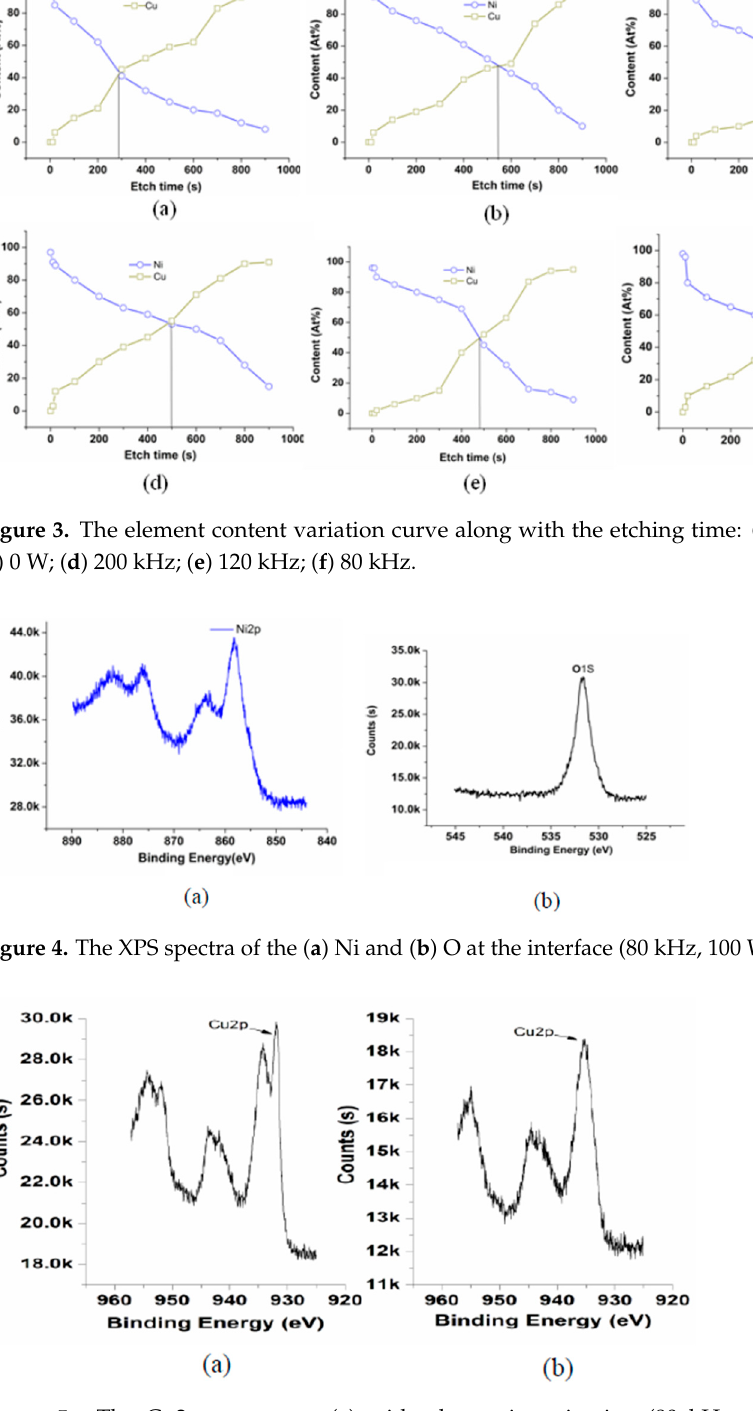
Figure 5. The Cu2p spectrum: ( a ) with ultrasonic activation (80 kHz, 100 W); ( b ) without ultrasonic activation.